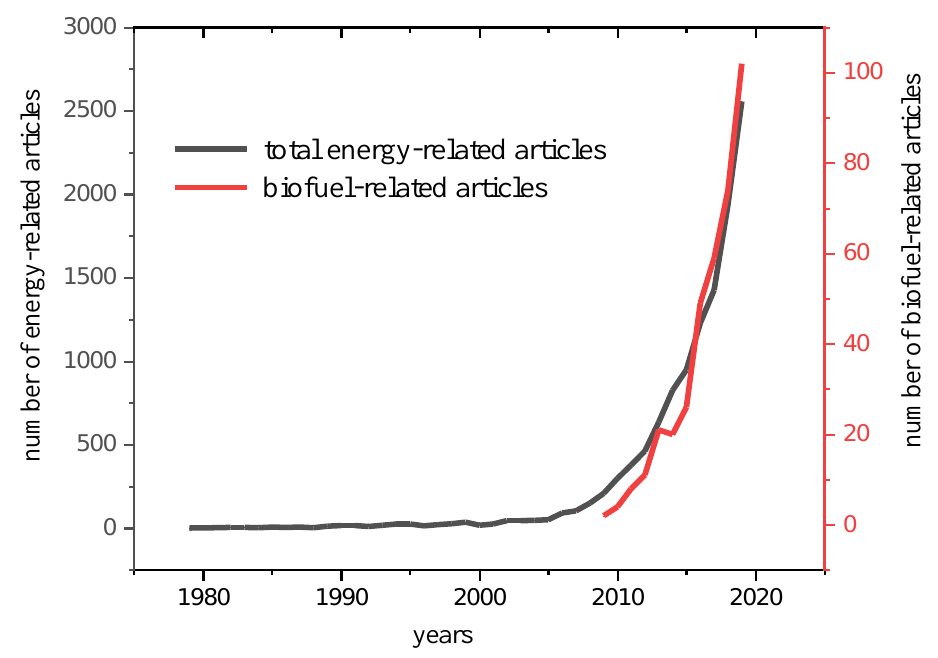
Figure 2. The number of articles applying the AHP to energy-related decision analysis in general, and to biofuel-related decision analysis in particular, based on Scopus.